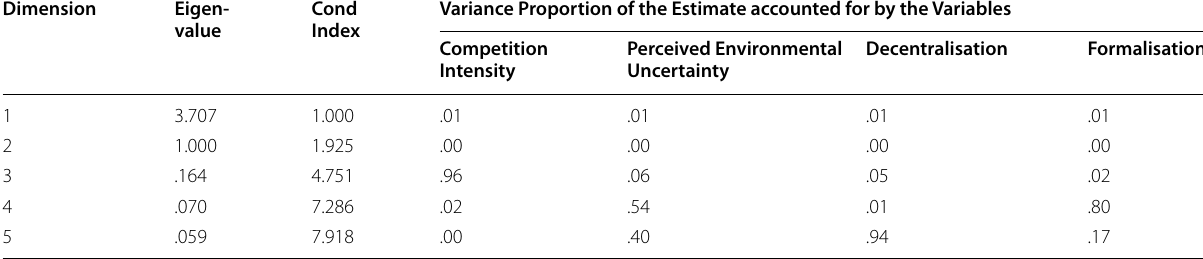
Table 7 Collinearity diagnostics for dependent variable customer accounting (CA)